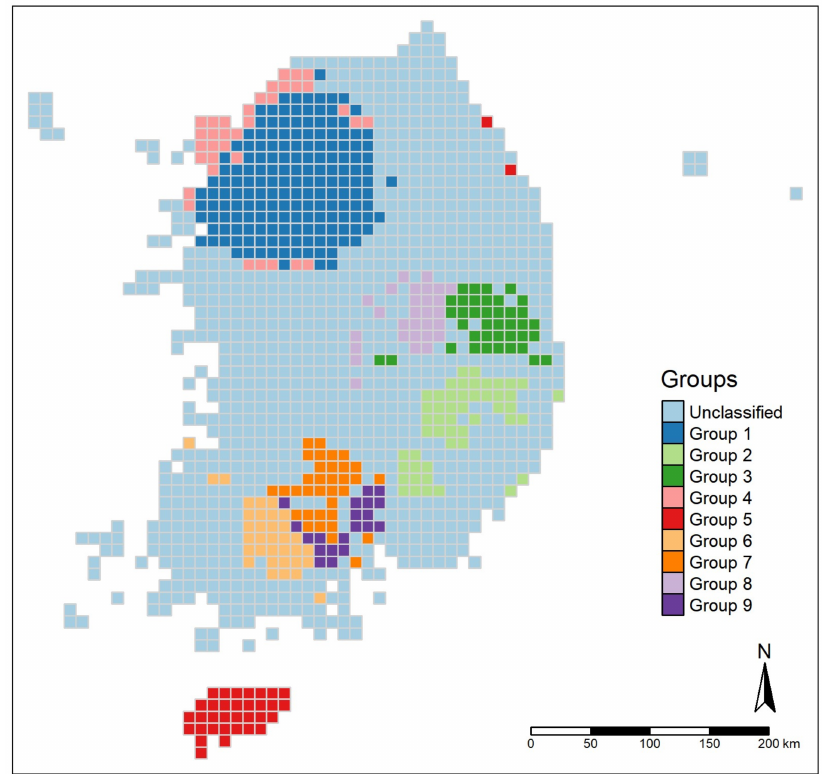
Figure 8. Spatial classification based on the combination of the variables with non-zero loadings from the local sparse